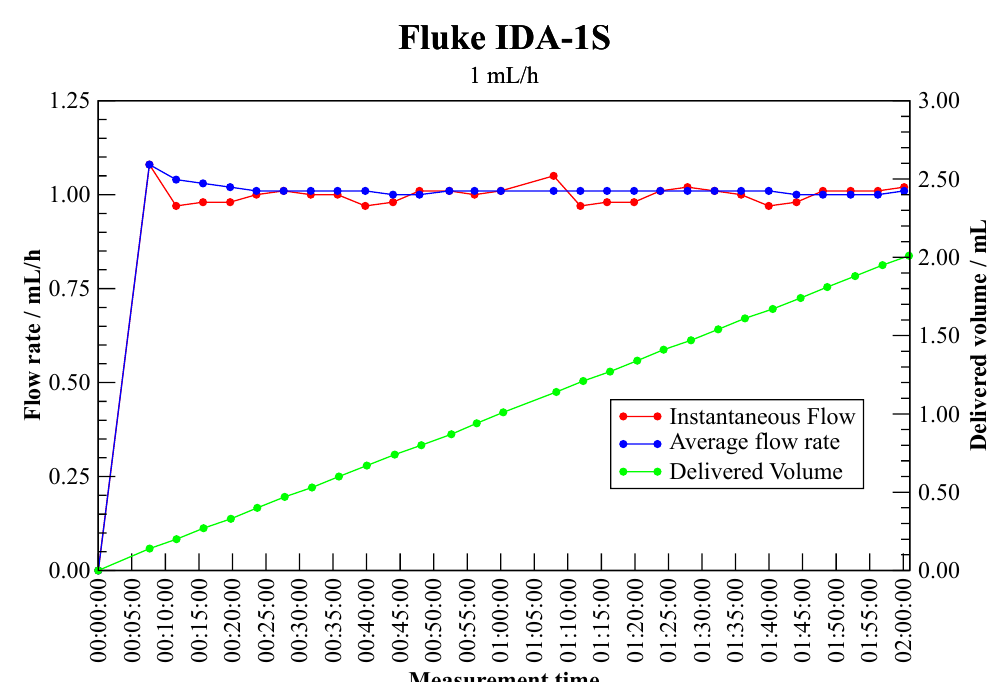
Figure 8. Typical calibration curve as produced by the HydroGraph software during a test. The red curve shows the instantaneous flow rate, the blue curve the average flow rate and the green curve the delivered